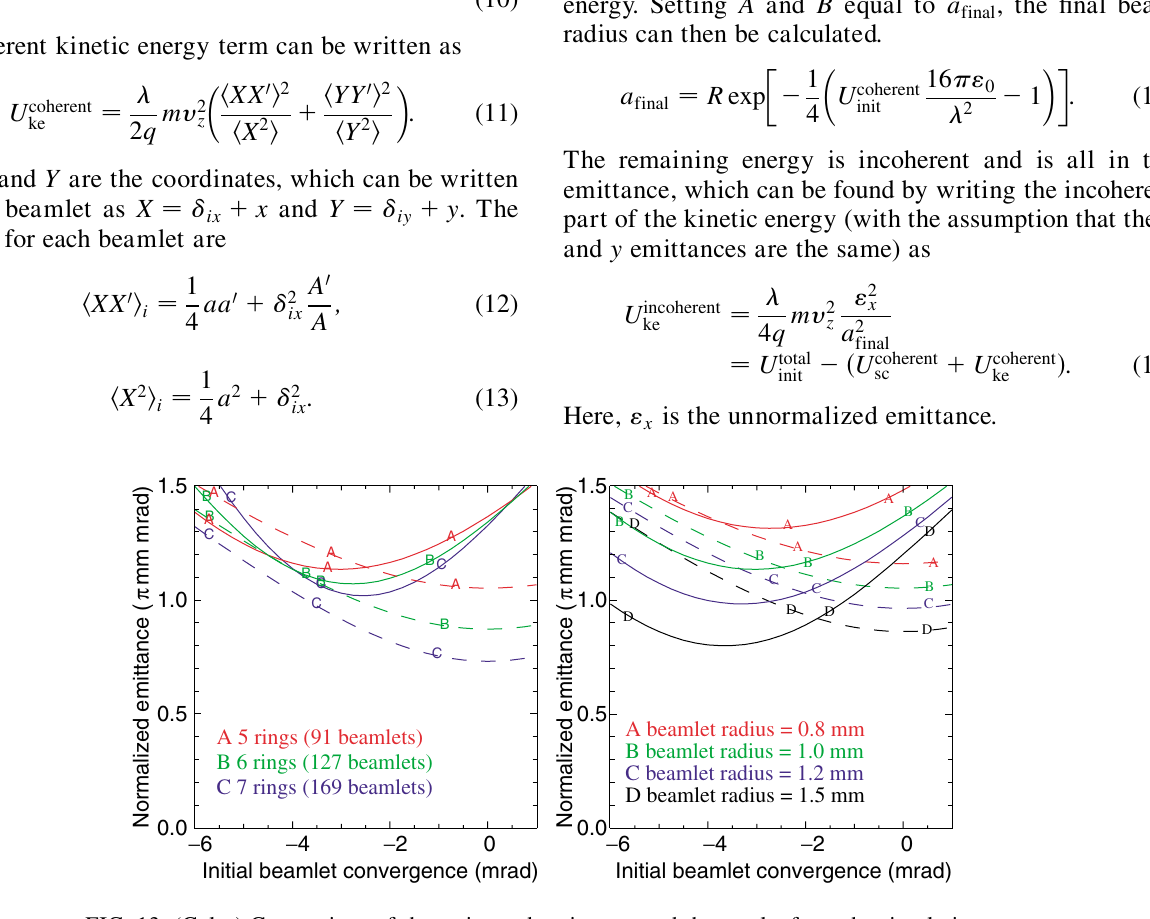
FIG. 13. (Color) Comparison of the estimated emittance and the results from the simulations. The solid curves are from the simulations, the dashed curves the